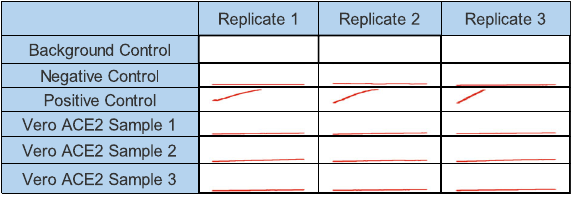
Fig. 6 ACE2 enzymatic activity assessment across Vero ACE2 samples. Vero ACE2 activity assay Reading Matrix